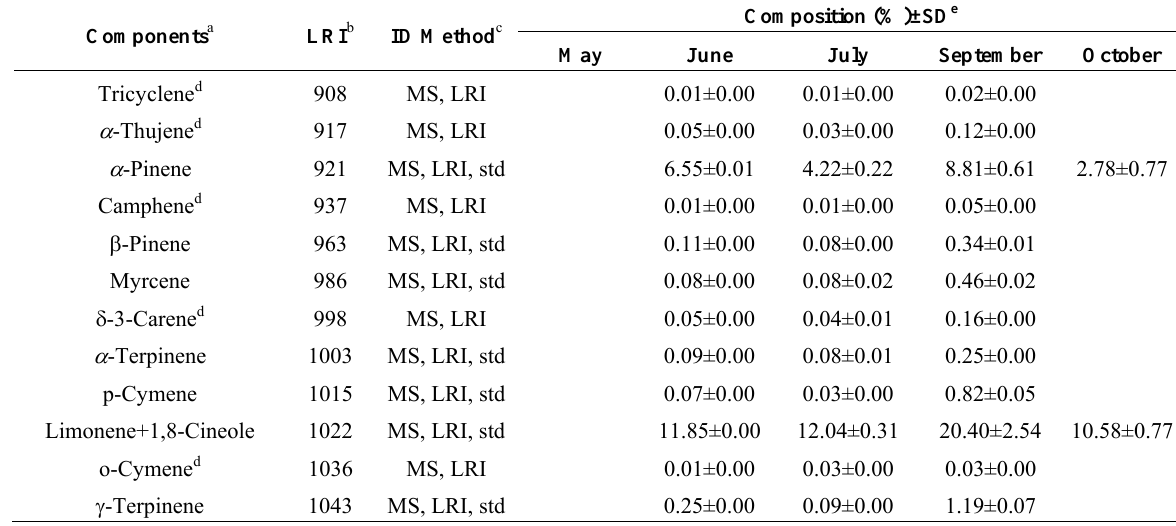
Table 3. Composition of the branches essential oil of Portuguese